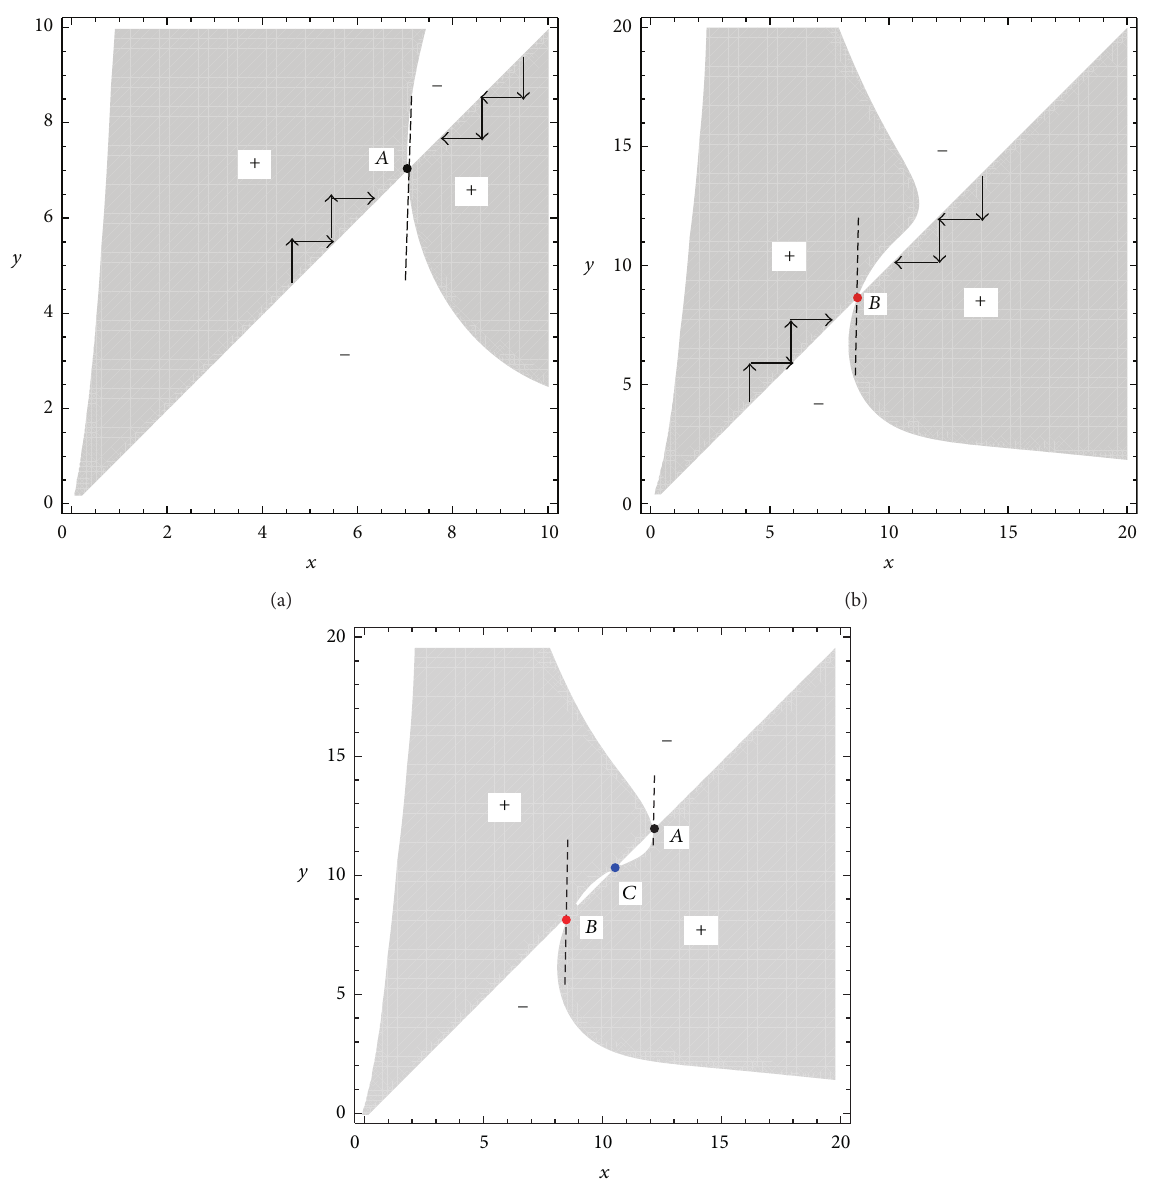
Figure 1: Pairwise invasibility plots. The resident and mutant strategies are denoted by 𝑥 and 𝑦 , respectively. The shaded areas marked with “+” indicate the combinations of 𝑥 and 𝑦 for which the fitness of the mutant, 𝑠 𝑥 (𝑦) , is positive. Arrows indicate the direction of disruptive selection which implies convergent stability. Black bullet 𝐴 = evolutionarily stable singular strategy, red bullet 𝐵 = evolutionary branching point, and blue bullet 𝐶 = repeller. (a) Only one singular strategy is a CSS when 𝑝 = 0.5 ; (b) only one singular strategy is an evolutionary branching point when 𝑝 = 6 ; and (c) multisingular strategies 𝑝 = 8 . Model parameters: 𝑎 = 200 , 𝑏 = 10 , 𝜇 = 6 , 𝜎 = 10 , 𝑐 = 2 , V = 0.8 , 𝐾 = 0.3 , and 𝜆 = 10.25